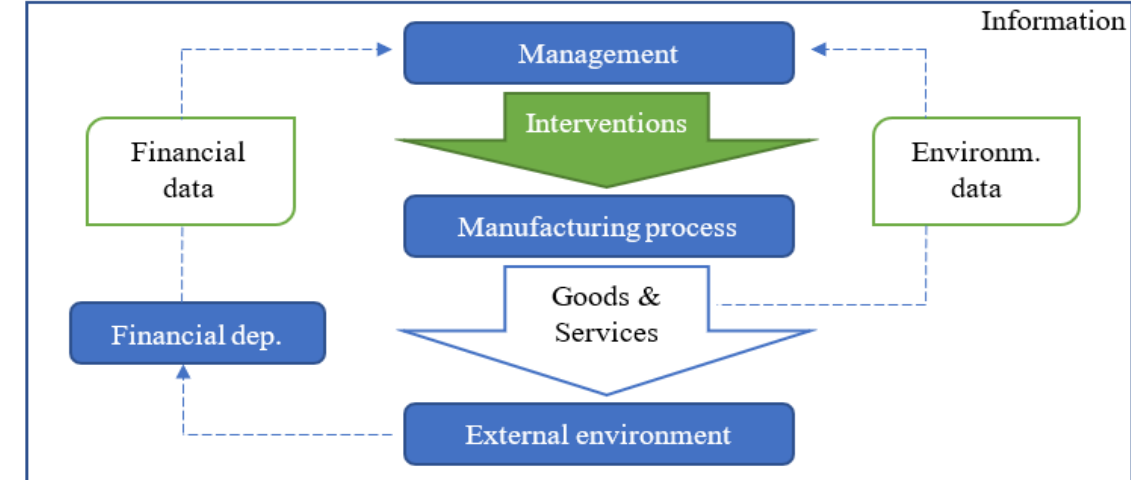
Figure 1. The process of obtaining and evaluating information in a manufacturing enterprise. Source: own